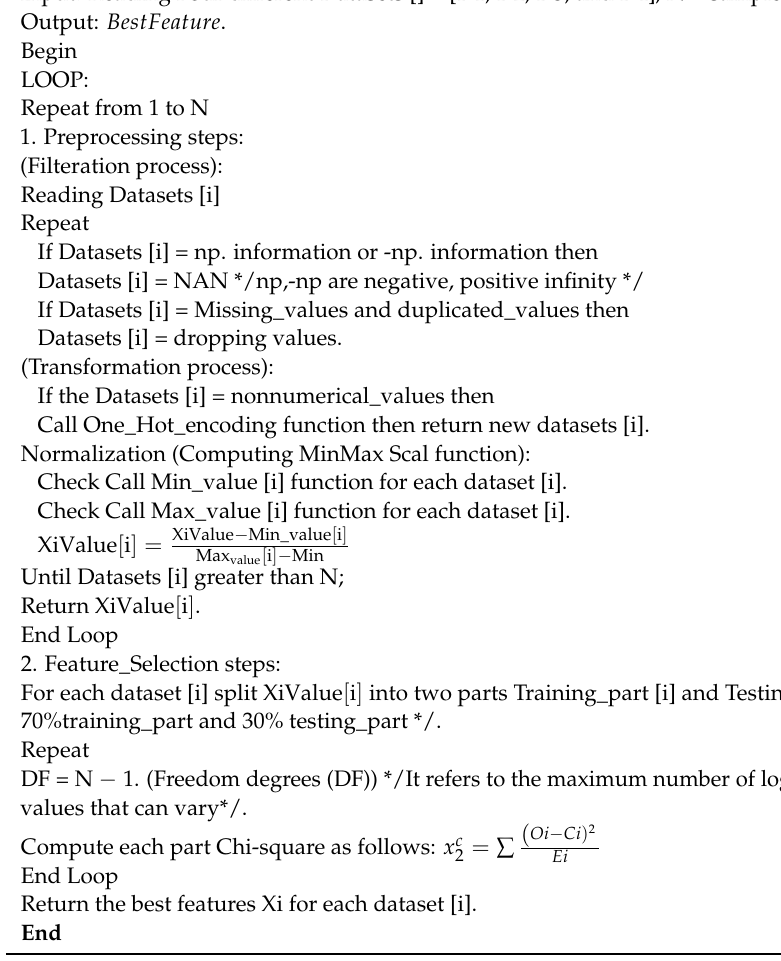
Algorithm 1. Preprocessing and